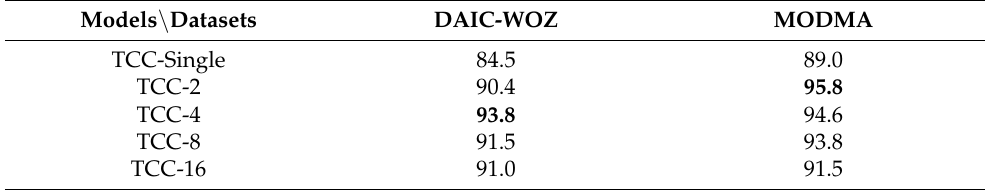
Table 1. The unweighted accuracies (%) of the proposed TCC approach with different numbers of heads in the multi-head attention mechanism (TCC-Single, TCC-2, TCC-4, TCC-8, and